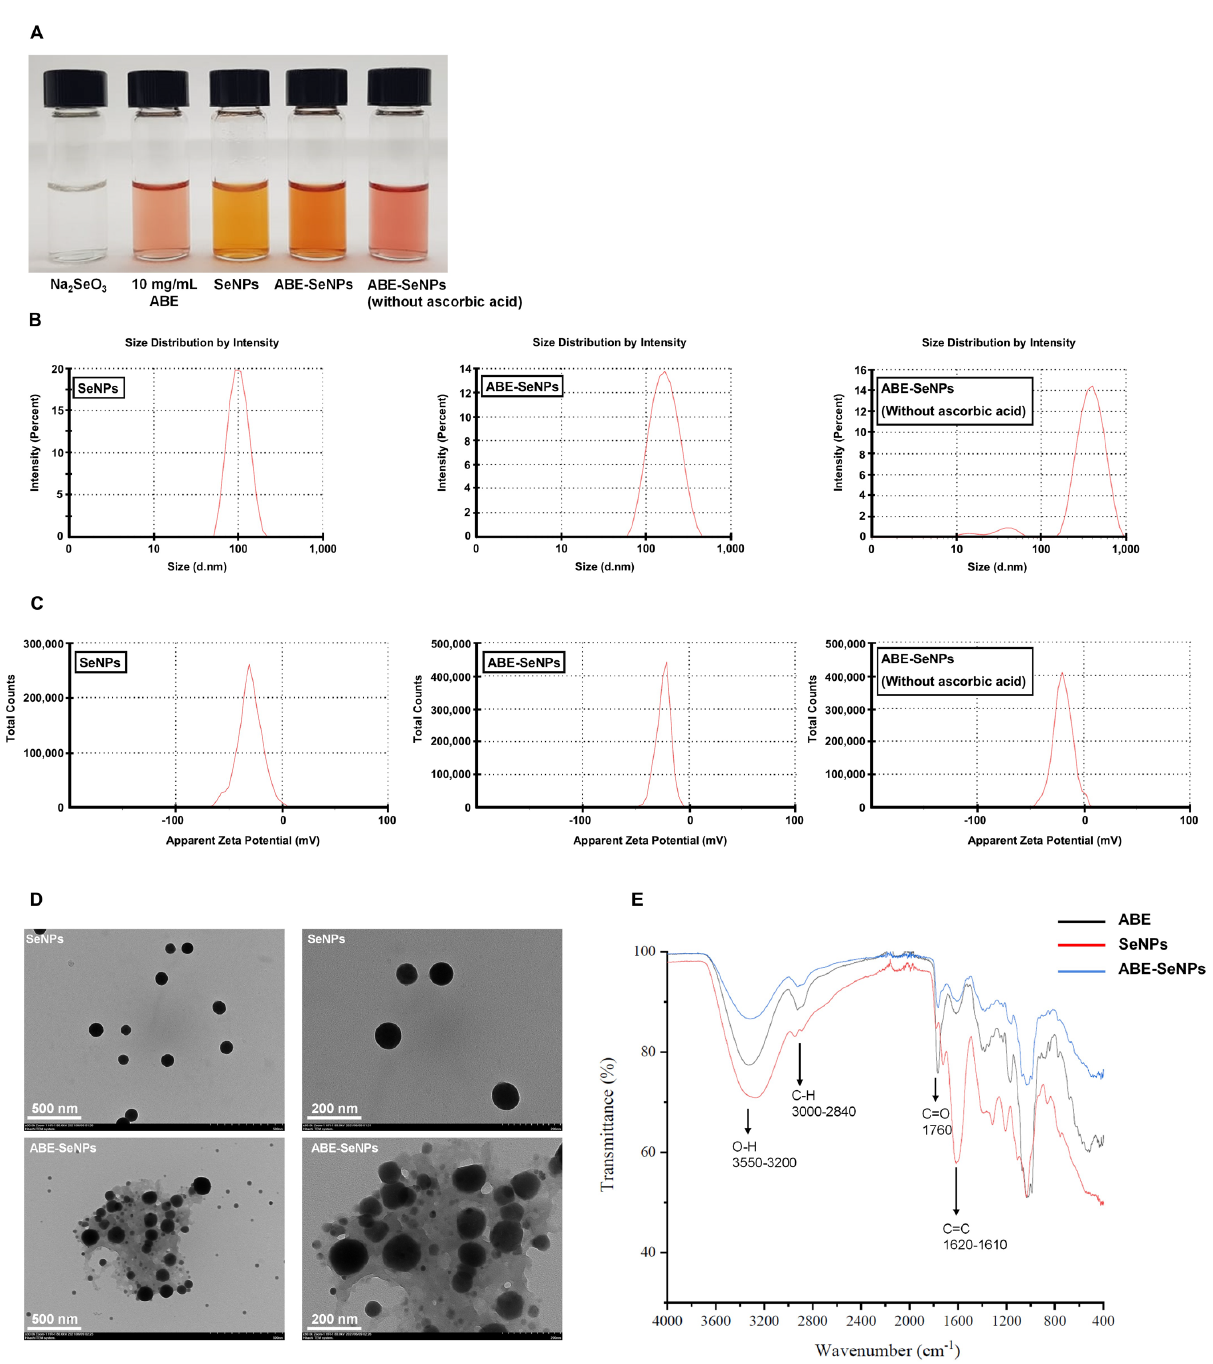
Figure 1. Physical properties of SeNPs and ABE-SeNPs. Color of the selenium salt, ABE, and the nanoparticle solution ( A ), size distribution ( B ), zeta potential ( C ), and morphology of SeNPs and ABE-SeNPs observed by TEM ( D ), and FTIR spectra of ABE, SeNPs, and ABE-SeNPs ( E ). The morphology of the nanoparticles observed by transmission electron microscopy (TEM) analysis was found to be spherical (Figure 1D). Interestingly, ABE-SeNPs showed the background surrounding the nanoparticles, but that was not observed in SeNPs, sug- gesting that selenium nanoparticles might be enclosed/wrapped with organic compounds of ABE. In addition, Fourier transform infrared spectroscopic analysis (FTIR) confirmed